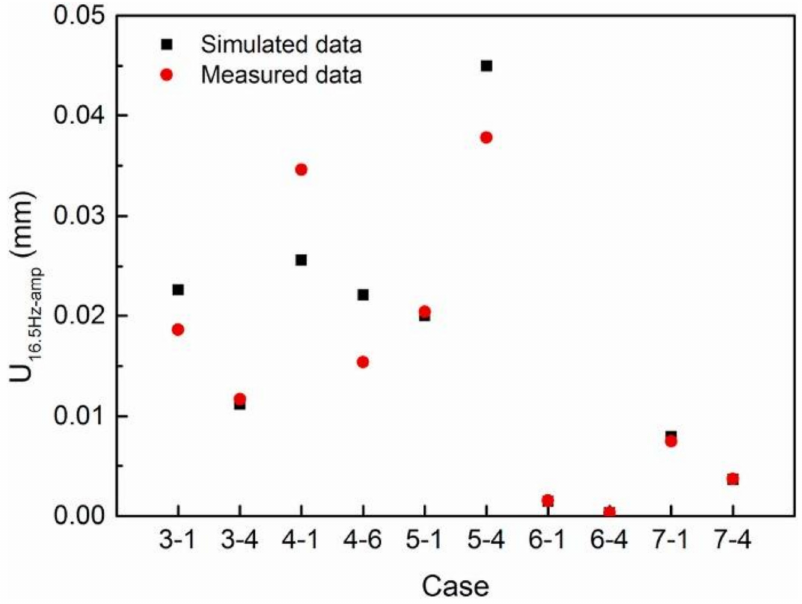
Figure 22. A comparison of the vibration displacement amplitude at the main frequency of 16.5 Hz